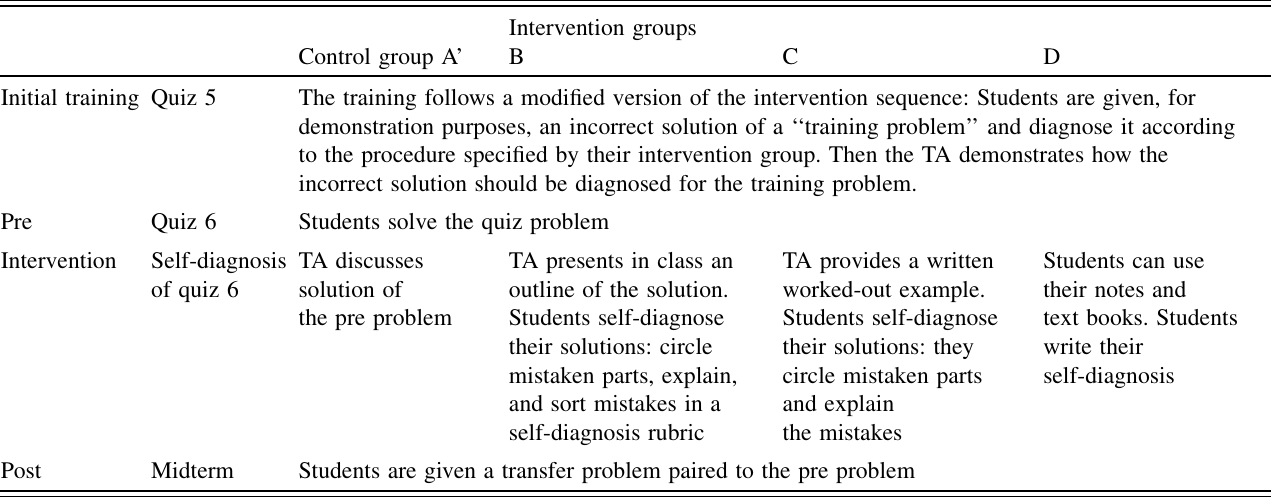
TABLE II. Experimental sequence. TA refers to the teaching assistant.